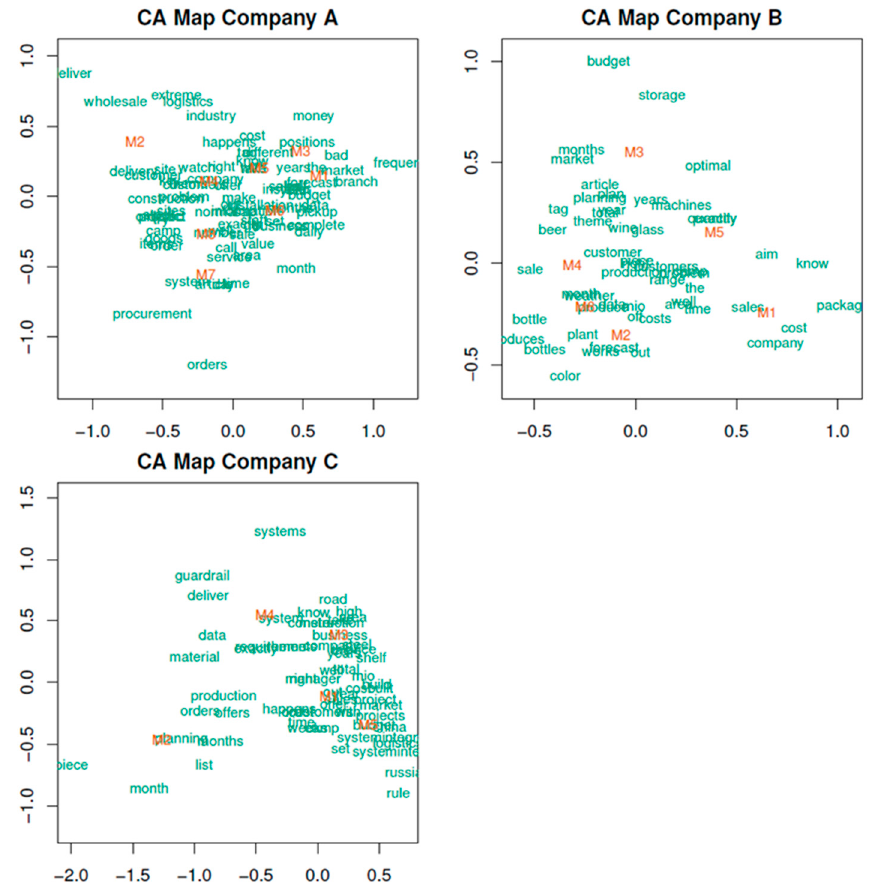
Figure 2. Symmetric CA maps for companies A, B, and